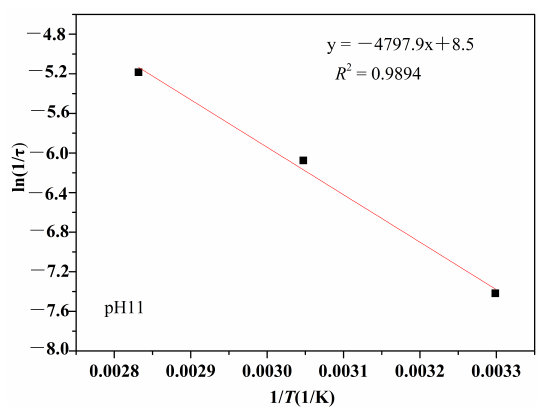
Figure 7. Exponential viscosity decay plots at pH